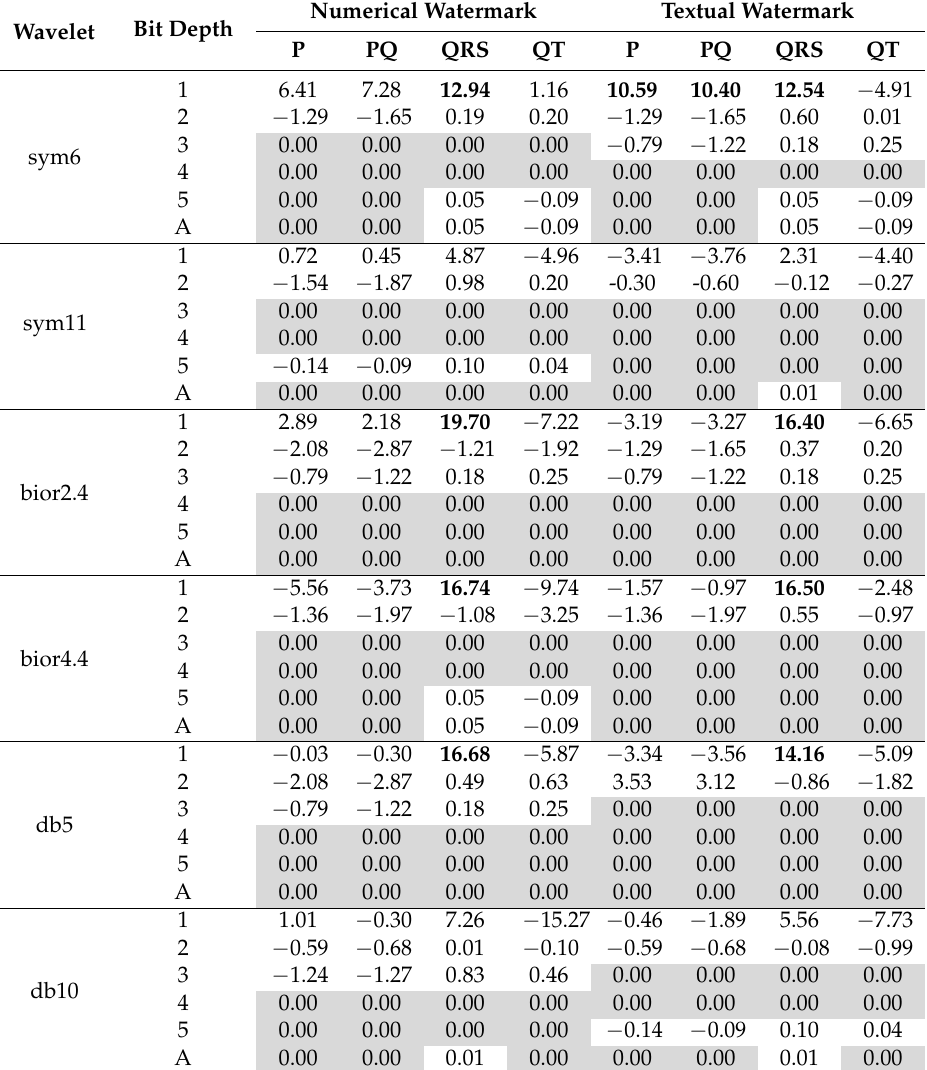
Table 1. Average difference values [ms] between results on IEC interval length calculated from 100 clean and watermarked ECGs; gray background indicates cases with identical results; boldface indicates differences exceeding the IEC requirement (10 ms for P, P-Q, QRS and 30 ms for Q-T); letter ‘A’ in coding bit depth column stands for automatic adjustment dependent on noise